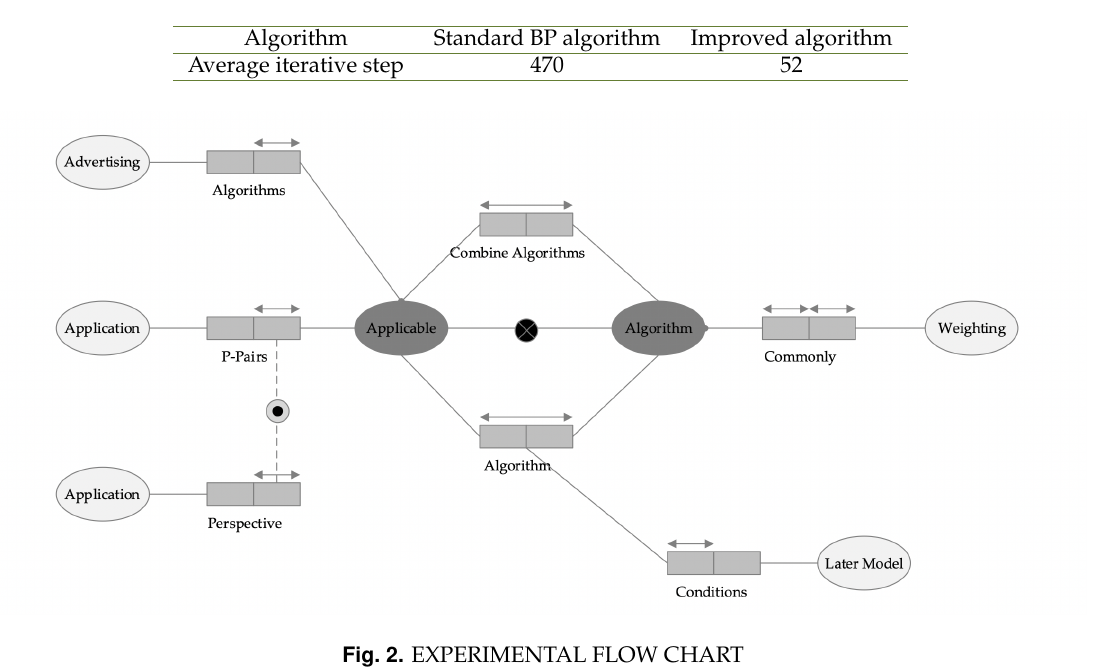
Table 3. COMPARISON OF SIMULATION RESULTS BETWEEN STANDARD BP ALGORITHM AND IMPROVED